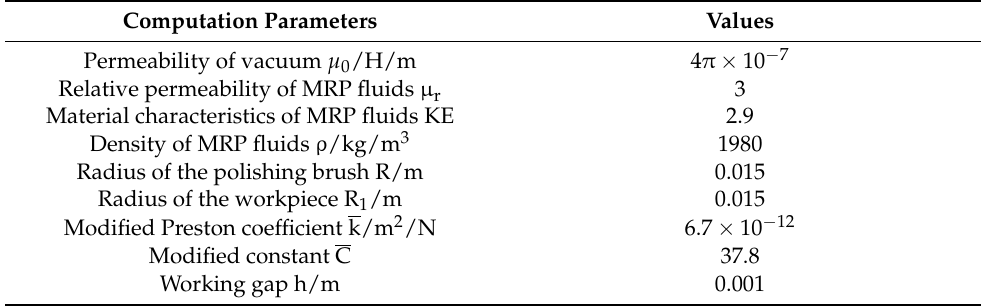
Table 1. The computation parameters of material removal rate (MRR) by the reciprocating magne- torheological polishing